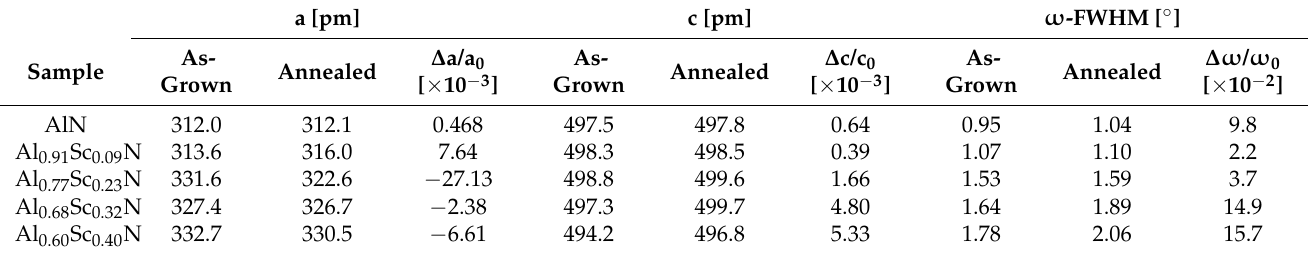
Table 2. Lattice parameters and mosaicity analyses of Al 1 − x Sc x N (0 ≤ x ≤ 0.4) thin films by XRD before and after thermal annealing (sample set